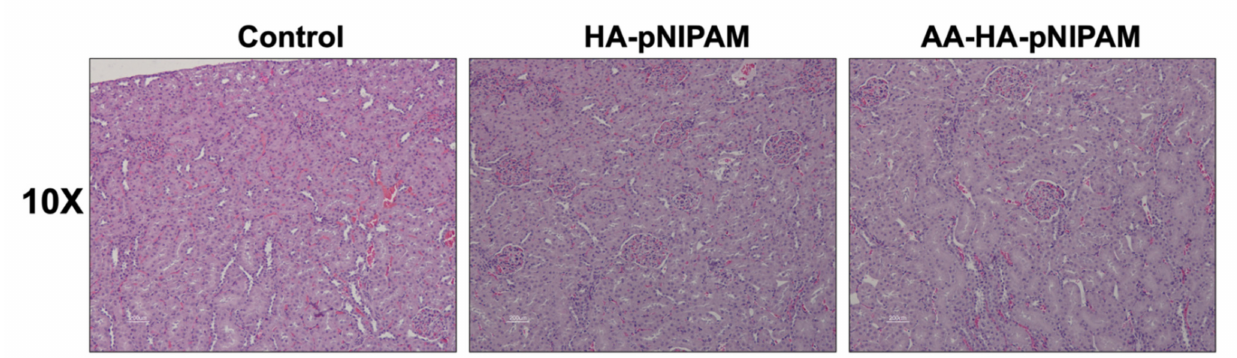
Figure 10. Microscopic images of livers from rats treated with UPW, HA-pNIPAM and AA-HA-pNIPAM. Hematoxylin and eosin (H&E) staining; 10 × and 20 × magnification.